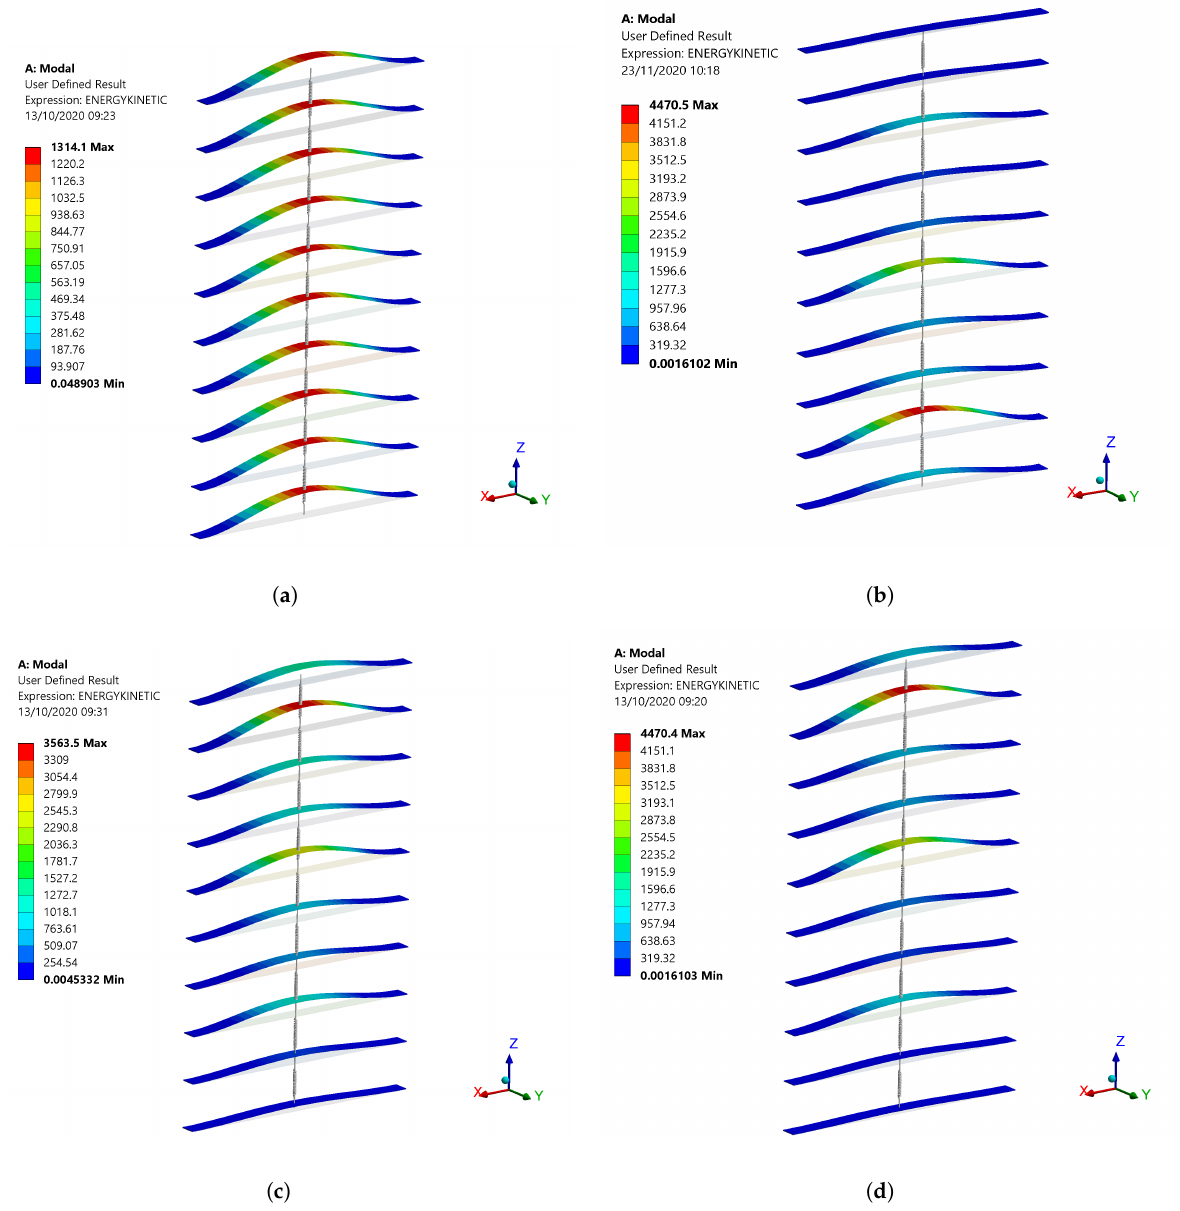
Figure 2. Bending vibration mode of the coupled beam system subjected to variations in mass density by ( a ) 0% (periodic system), ( b ) 10% of the 2nd, 5th and 8th beams counting from the bottom, ( c ) 6% and ( d ) 10% of the 3rd, 6th and 9th beams counting from the